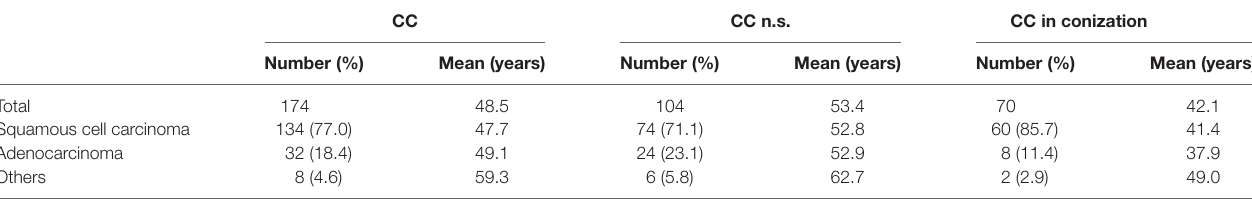
Table 1 | Number and mean age of histological subtypes of cervical cancer (CC) depending on type of diagnosis, CC diagnosed by conization and CC diagnosed other than by conization. cc cc n.s.